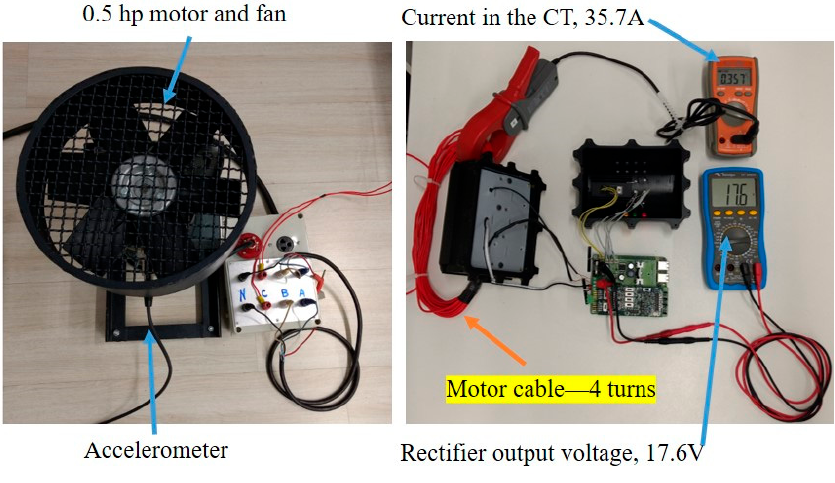
Figure 13. Test setup for the SSWCT.